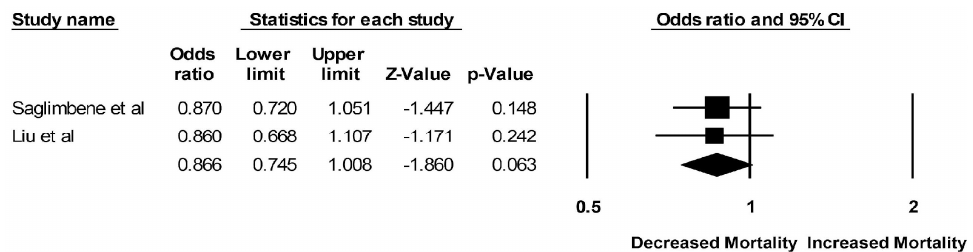
Figure 2. Forest plots of the included studies assessing outcomes defined as DASH and Mediterranean and all-cause mortality [15,20].